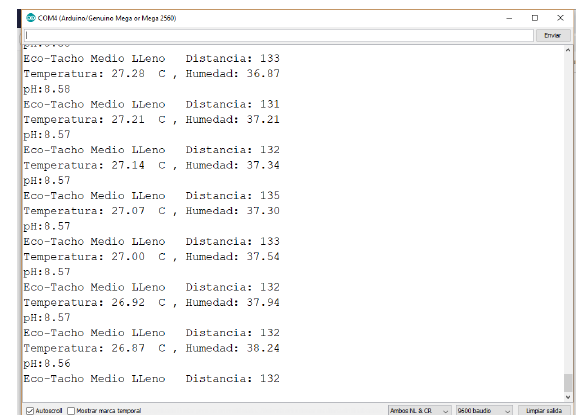
Figure 12. Data capture from NS and NG.